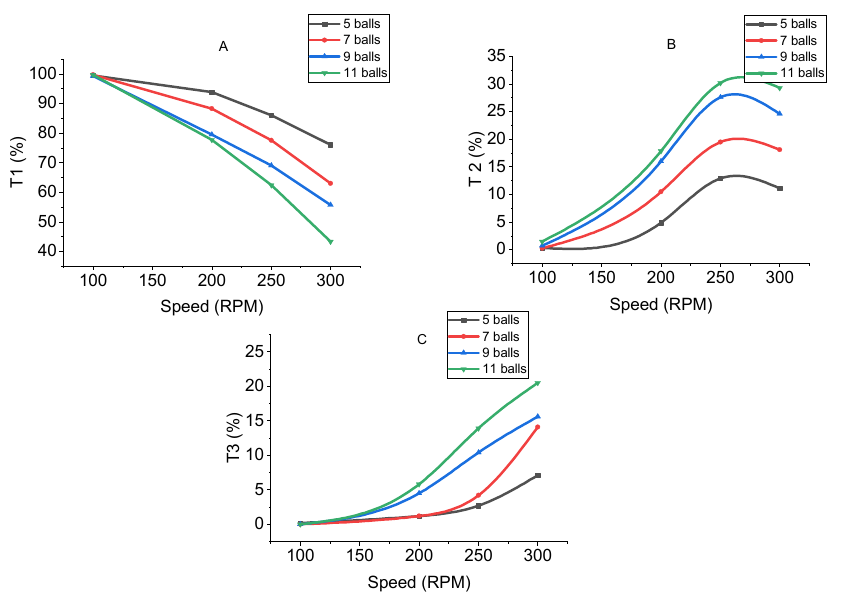
Figure 5. ( A – C ) plots of T1, T2 and T3 vs. Milling speeds (bed mass = 250 g, varied number of balls, shaking time 20 min).